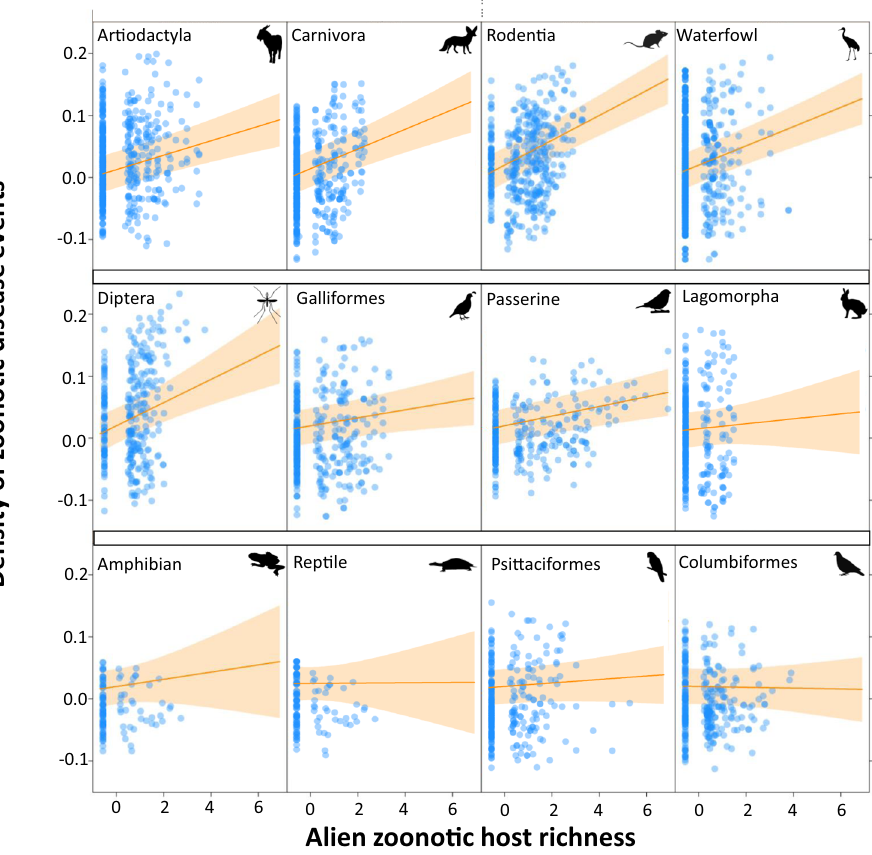
Fig. 5 The relationship of alien zoonotic animal richness and the zoonosis emergences across alien host groups. The strength of each host group is tested by including an interaction between the richness of alien zoonotic species with each of the 12 host orders identi fi ed as important in the GAMMs after accounting for other co-factors. Each host order had established alien populations in at least 50 administrative units. Lines show the predicted relationship between density of zoonotic disease events and alien zoonotic host richness, with mean and the shaded area as the 95% con fi dence band (Supplementary Data 4). All predictor variables were standardized (to a mean of zero and standard deviation of one) before entering the model. Animal silhouettes were obtained from